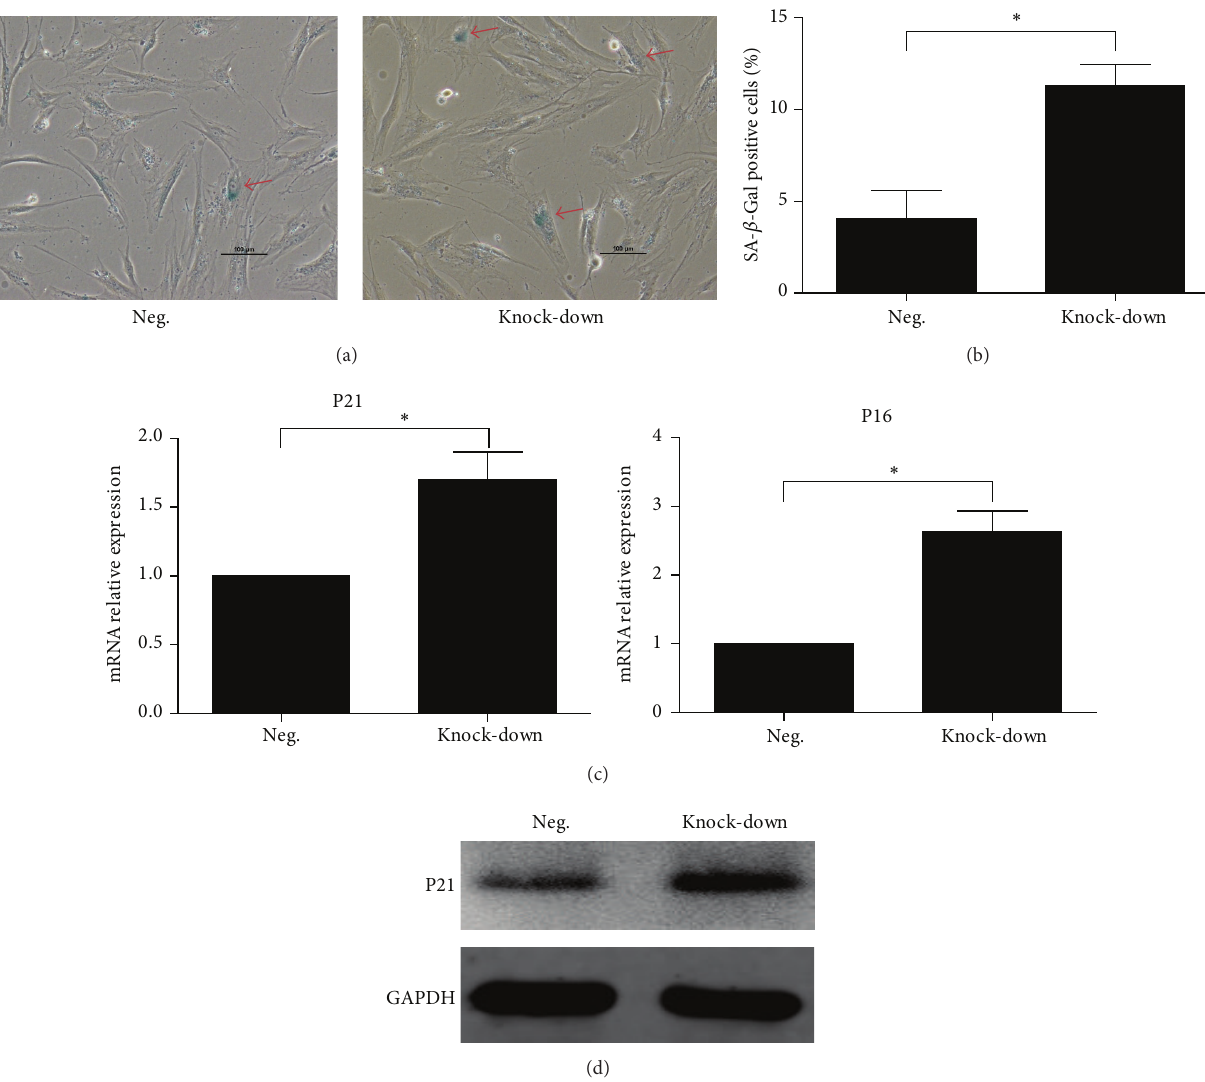
Figure 5: Senescence analysis of transfected BM-MSCs. (a) Representative SA- 𝛽 -Gal activity in different groups. Scale bar = 100 𝜇 m. (b) Percentage of SA- 𝛽 -Gal positive cells was quantified in different groups. Data was presented as mean ± SD. (c) Mean relative values ( ± SD) of P21 and P16 mRNA expression in different groups. (d) The confirmation of P21 upregulation in knock-down group by western blot